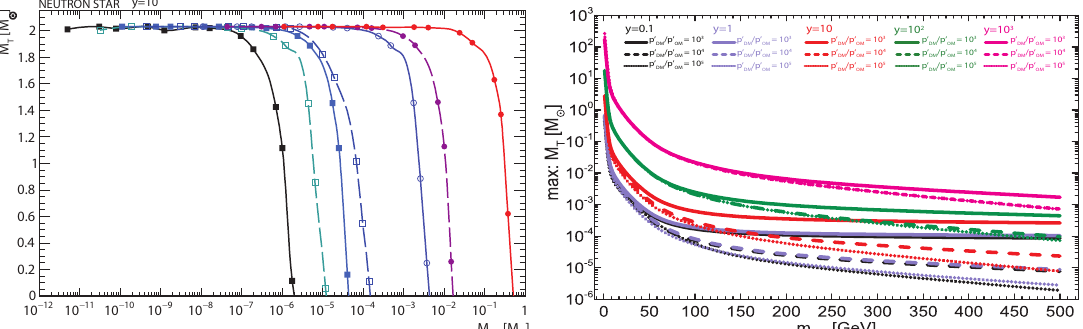
Figure 1. Left panel: The maximum mass of a stable neutron star (NS) as a function of its dark matter (DM) mass content in the case of y = 10 − 1 , weakly interacting DM. Each curve corresponds to a given DM particle mass and is built from the last stable point of fixed p DM / p OM curves. They mark how, at fixed particle mass, the largest possible NS mass evolves for an increasing DM mass content. The colour codes the DM particle mass value. From left to right: 500,200,100,50,10,5,1 GeV. Right panel: the maximum mass of a stable NS as a function of the particle mass for DM, with various curves for different self interaction cross sections, coded by colour, and for the DM to ordinary matter ratio, coded by line